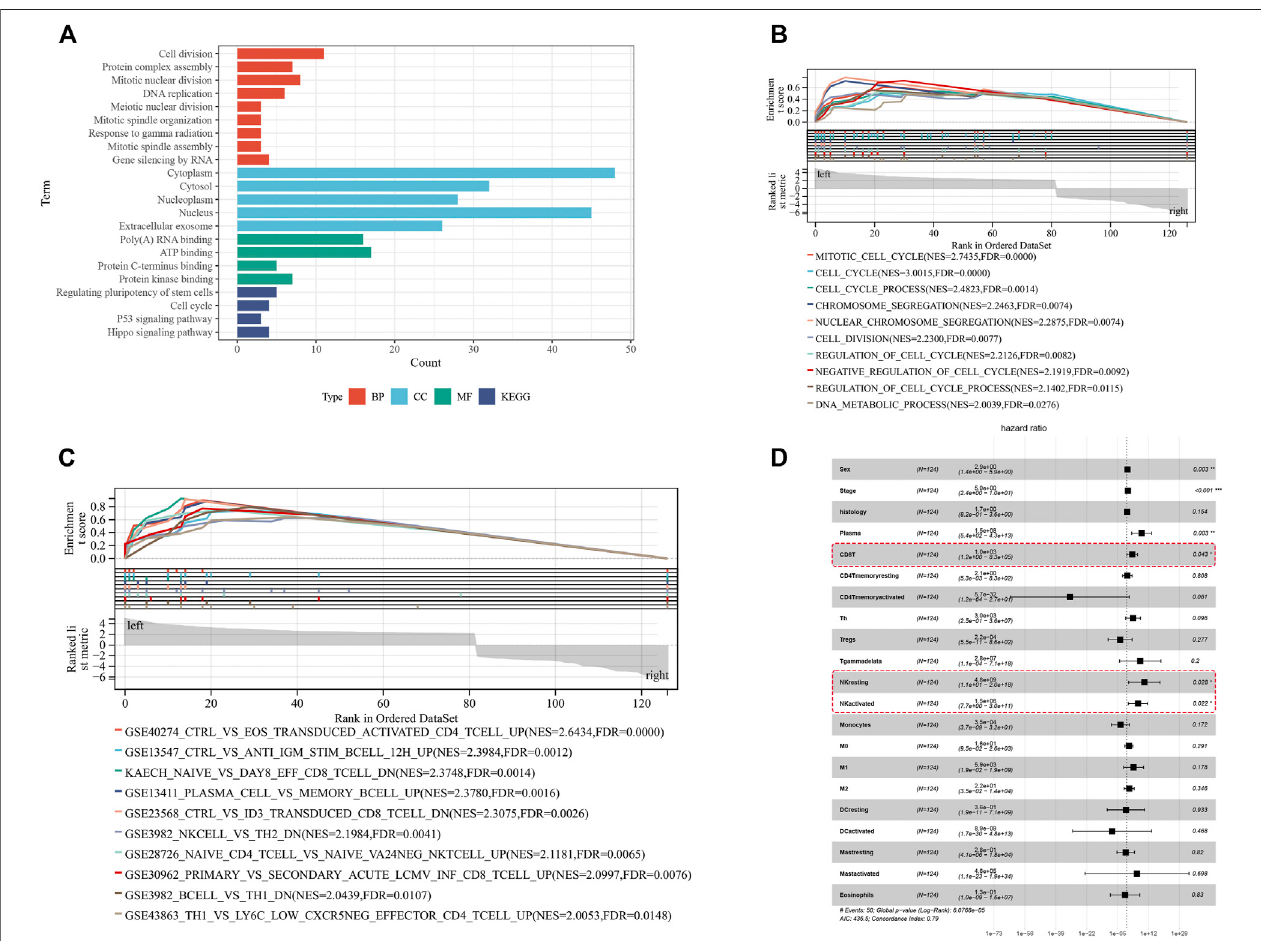
FIGURE 6 | Functional enrichment analysis of DE-mRs in the ceRNA network. (A) GO and KEGG enrichment analysis of DE-mRs in the ceRNA network. (B) Enrichment plot of GSEA analysis of DE-mRs in the ceRNA network based on ‘ C5 ’ curated gene sets. (C) Enrichment plot of GSEA analysis of DE-mRs in the ceRNA network based on immunologic signature gene sets. (D) Forest plot showing the prognostic associations of subsets of immune cells in Cox regression analysis. *: p < 0.05, **: p < 0.01, ***: p < 0.001.